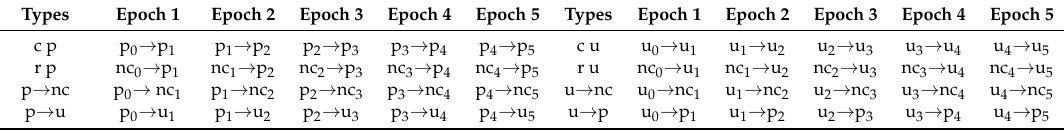
Table 3. Detailed information regarding the trajectory transformations for different